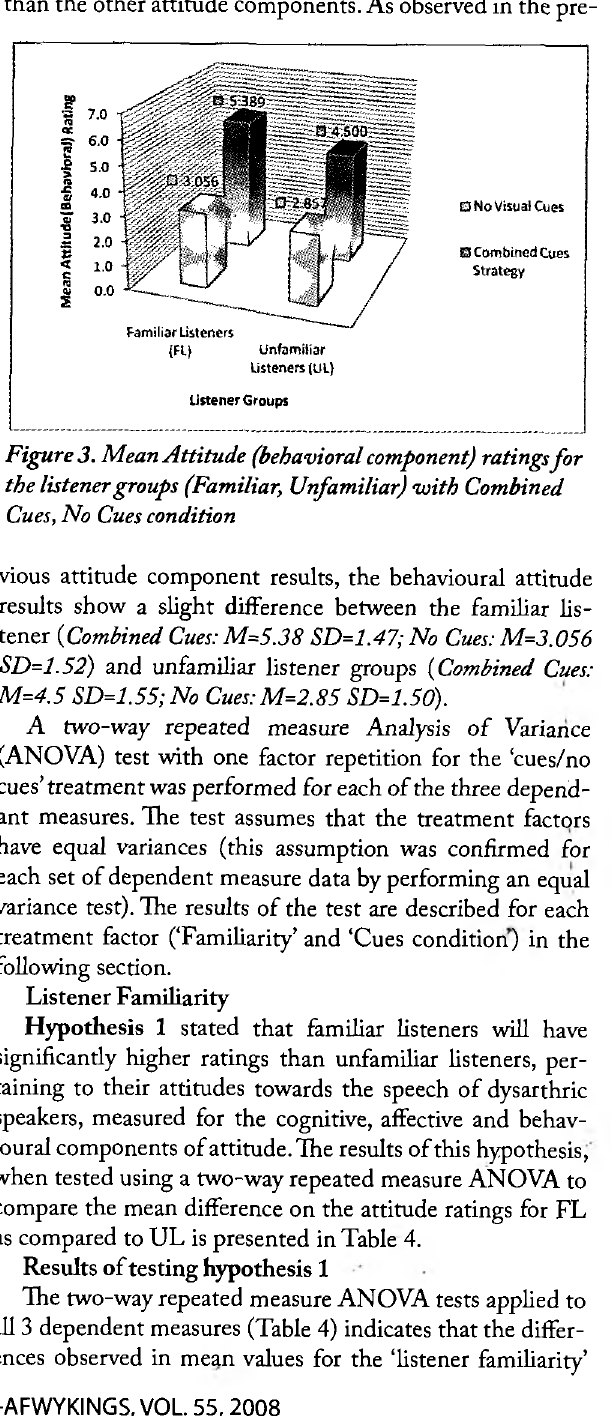
Figure 2. Mean Attitude (affective component) ratings for the listener groups (Familiar, Unfamiliar) with Combined Cues, No Cues condition